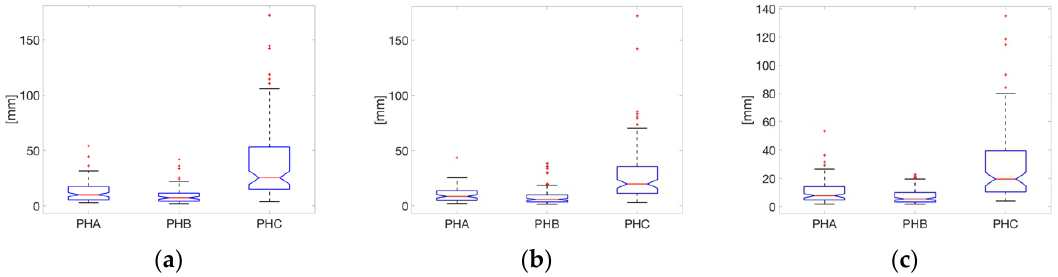
Figure 9. Range distributions for each of the three phases PHA, PHB and PHC: ( a ) RANGE distributions, ( b ) RANGEX distributions and ( c ) RANGEY distributions.